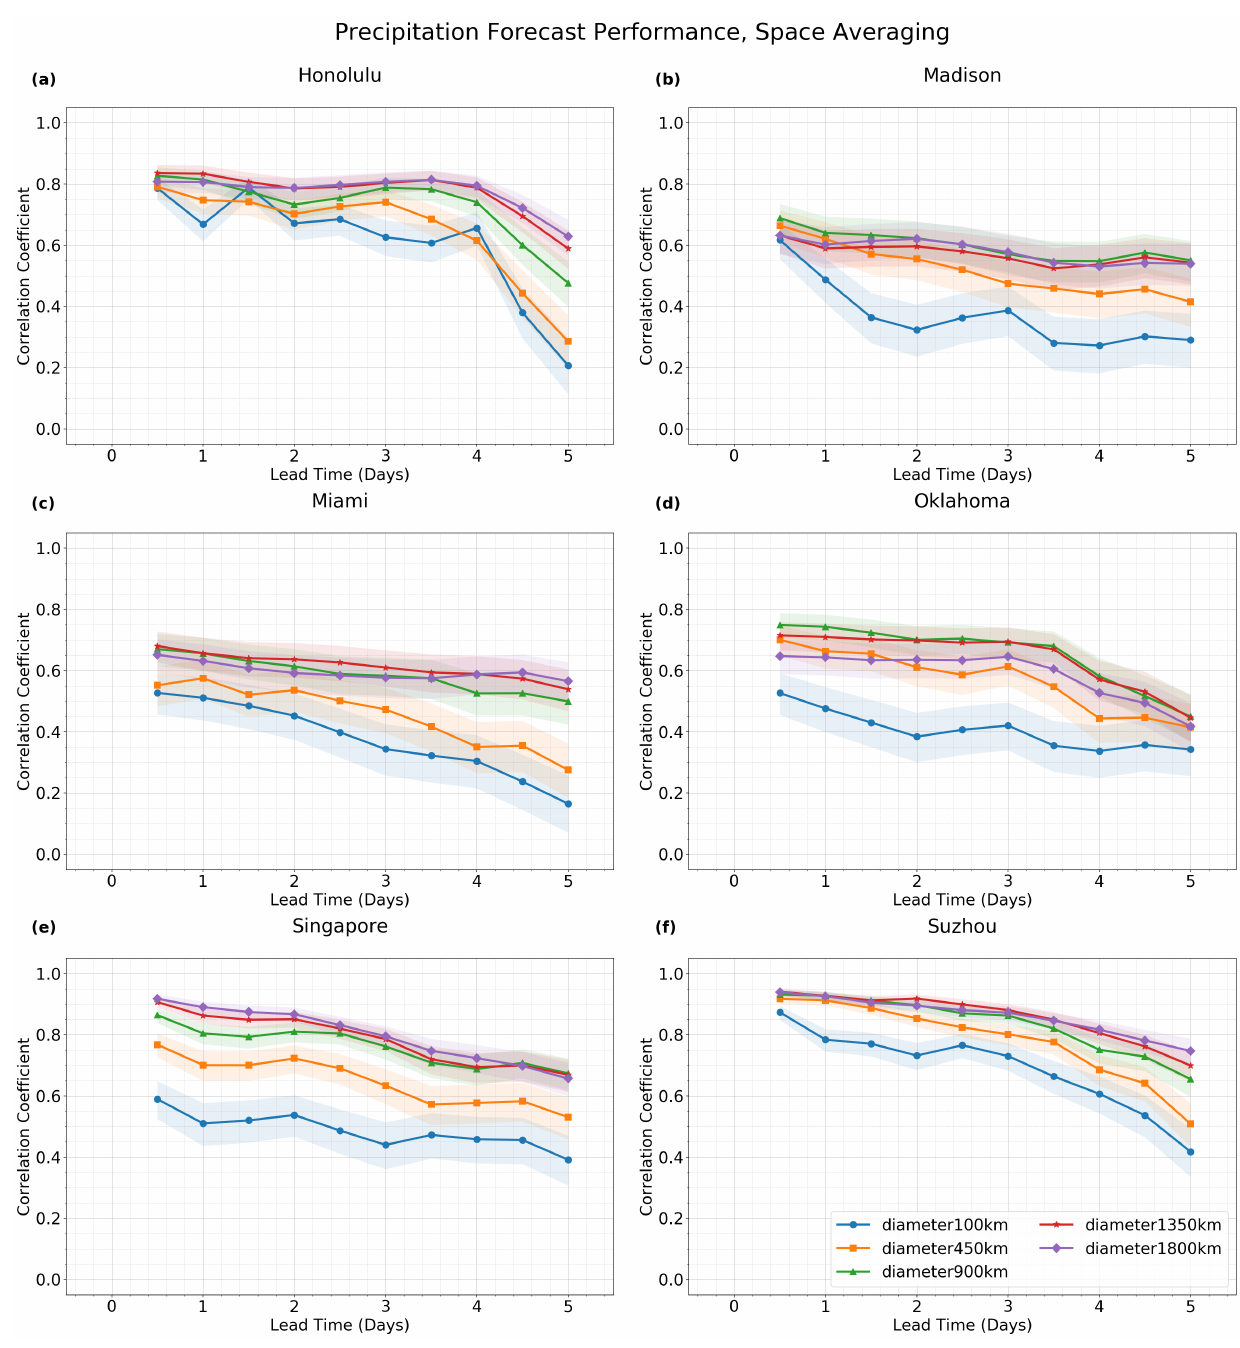
Figure 6. Effects of spatial averaging on forecast performance, for precipitation, with 1-day temporal averaging, at several locations around the globe: ( a ) Honolulu, Hawaii (21 ◦ N, 158 ◦ W), ( b ) Madison, Wisconsin (43 ◦ N, 89 ◦ W), ( c ) Miami, Florida (26 ◦ N, 80 ◦ W), ( d ) Oklahoma City, Oklahoma (35 ◦ N, 98 ◦ W), ( e ) Singapore (1 ◦ N, 104 ◦ E), and ( f ) Suzhou, China (31 ◦ N, 120 ◦ E). Compare to the effects of time averaging from Figure